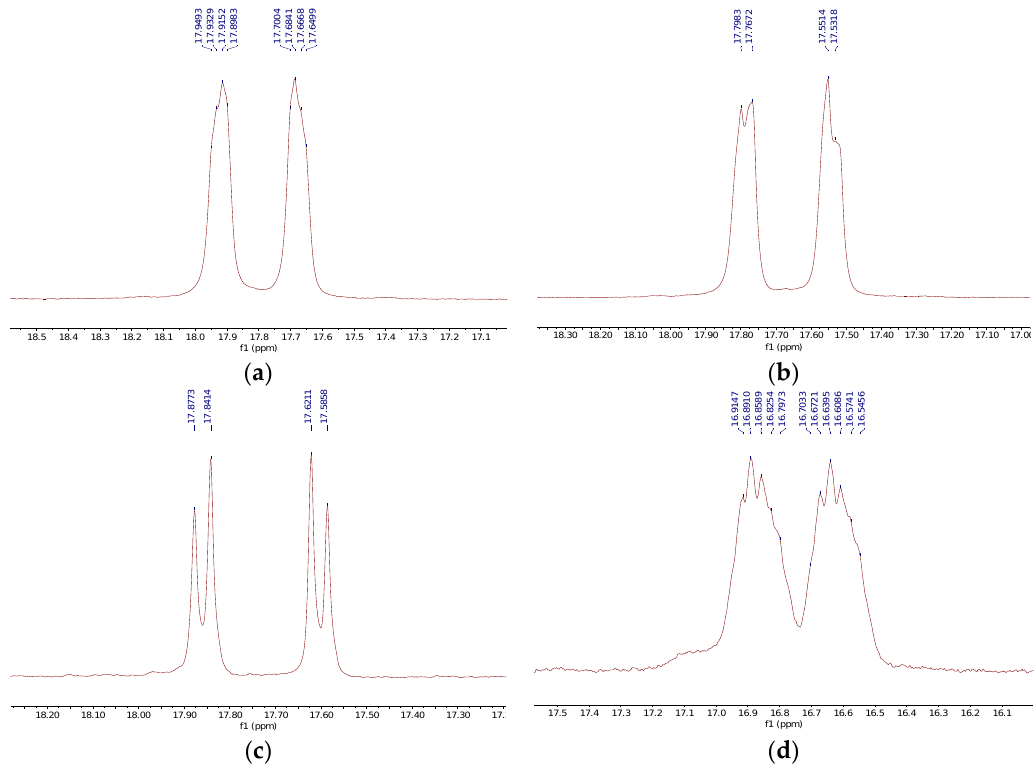
Figure 4. Products of reactions of various isomers of cyclohexane- 1,2 -diamines and (1 S ,2 S ) -cyclopentane- 1,2 -diamine.